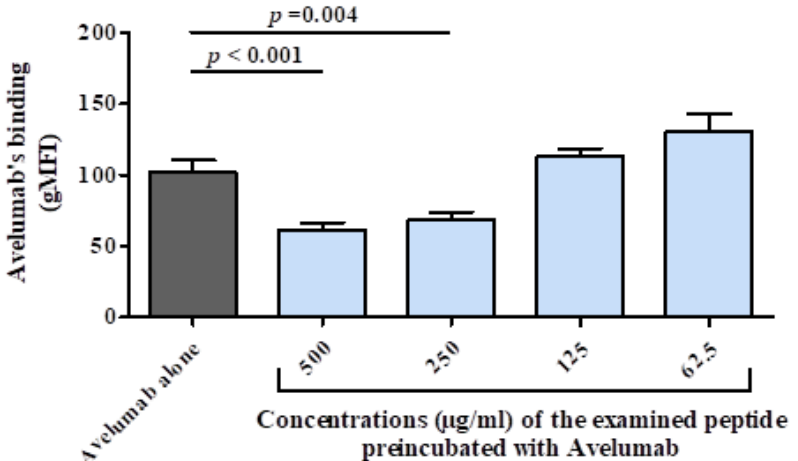
Figure 3. Examination of the ‘hybrid hPDL1-mimotope’ in cellular assay. Jurkat T cells expressing hPD-L1 were used in a cellular assay to assess the binding of avelumab (30 ng/mL) alone or after pre-incubation with different concentrations of the examined peptide. The values represent the mean and standard deviation of the geometric mean of the fluorescence intensity (gMFI) of the viable population of the cells from three independent experiments. Significant differences are indicated by the respective p -values.